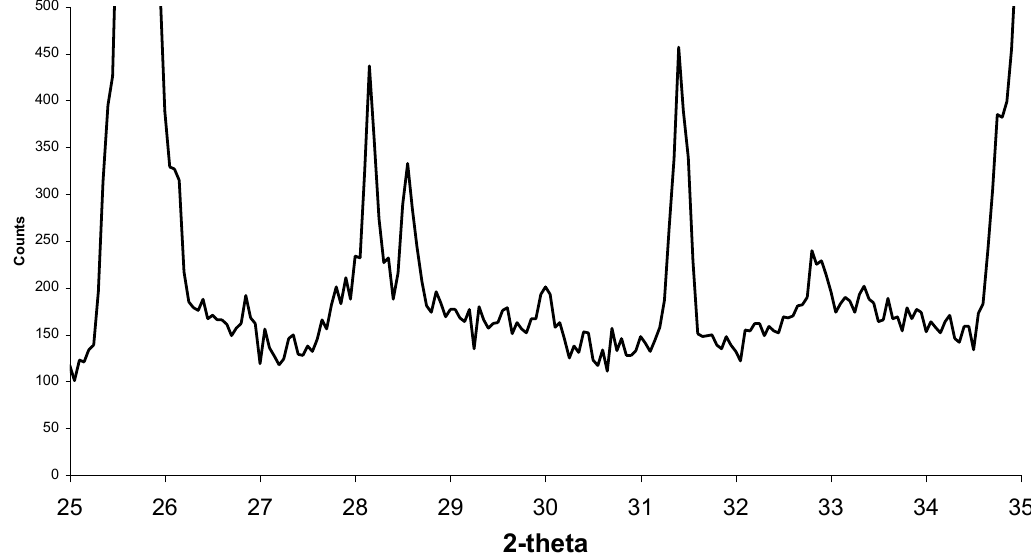
Figure 11. XRD scan of a select 2-theta showing a high magnification of the small peaks from Figure 10. Apatite peaks are now